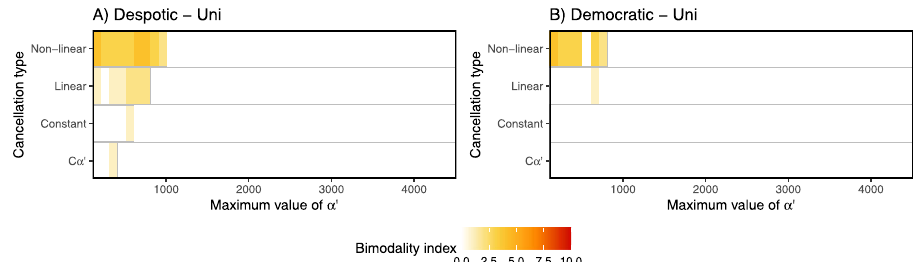
Fig. 3 Scenarios where a bimodal distribution of the number of responders was produced under the Uni condition. Scenarios where a bimodality was produced under A despotic or B democratic scenario, depending on the cancellation type ( y -axis) and the range of difference in α ’ values ( x -axis). The fi rst column of the x -axis corresponds to the control simulation without personality as α ’ = 160 for all individuals. For the following columns the minimum value of α ’ = 10 and the maximum value of the distribution is given by x -axis. The probability of joining per second (one timestep) is equal to 1/ α ’ . The colour scale indicates the bimodality index (see Methods for computation details); the higher the index, the higher the degree of bimodality (see also Supplementary Figs. S3 and S6).